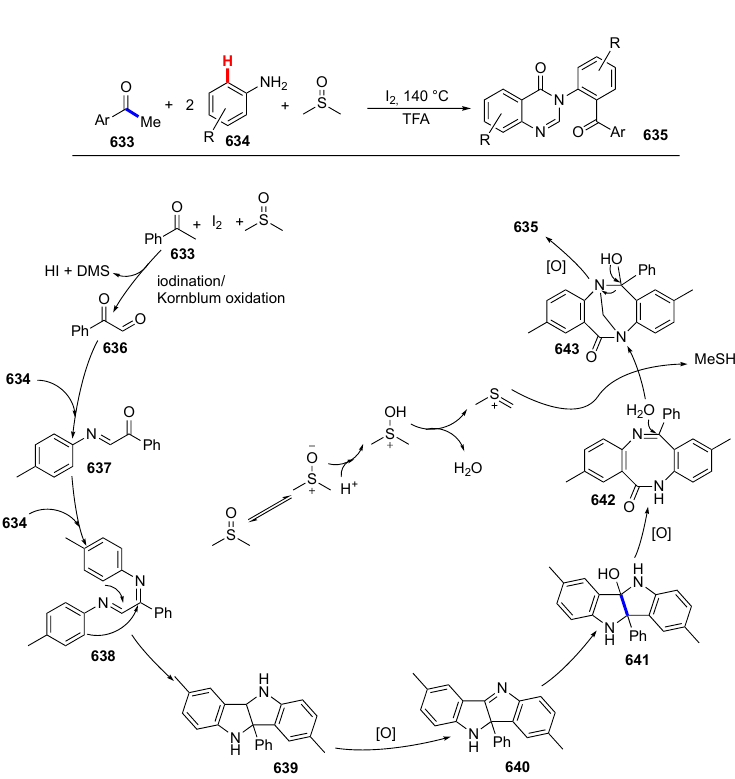
Scheme 82. Oxidative coupling of aniline and acetophenone derivatives.